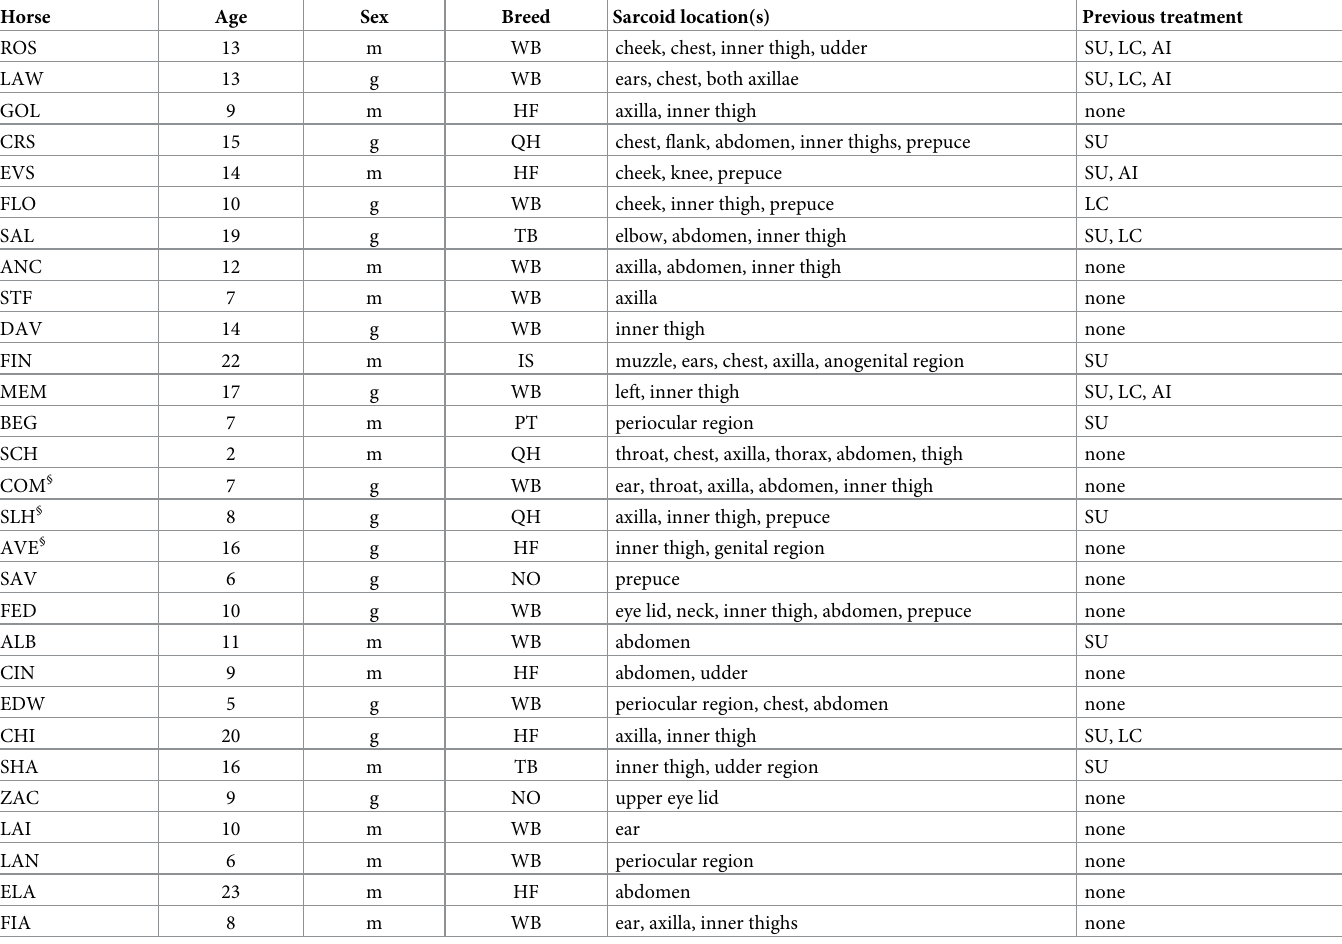
(Table 3; indicated by § ) that were unable to present at the Vetmeduni in time due to SARS- CoV2-related travel restrictions (Table 2). Several horses that stopped responding following completion of basic treatment received one or two additional booster injections with 9 log tored for local and systemic adverse effects as described above (safety trial). Tumour diameters were assessed in monthly intervals using callipers and by photography (Fig 2). In addition, patient owners gave feedback on a regular basis. In two cases (BEG, ZAC) showing complete sarcoid regression, it was possible to collect sample material (crusts, hair roots) from previous tumour sites during the last visit. Following DNA extraction from this material, BPV1/2 Table 2. Information on sarcoid-bearing horses enrolled in the patient